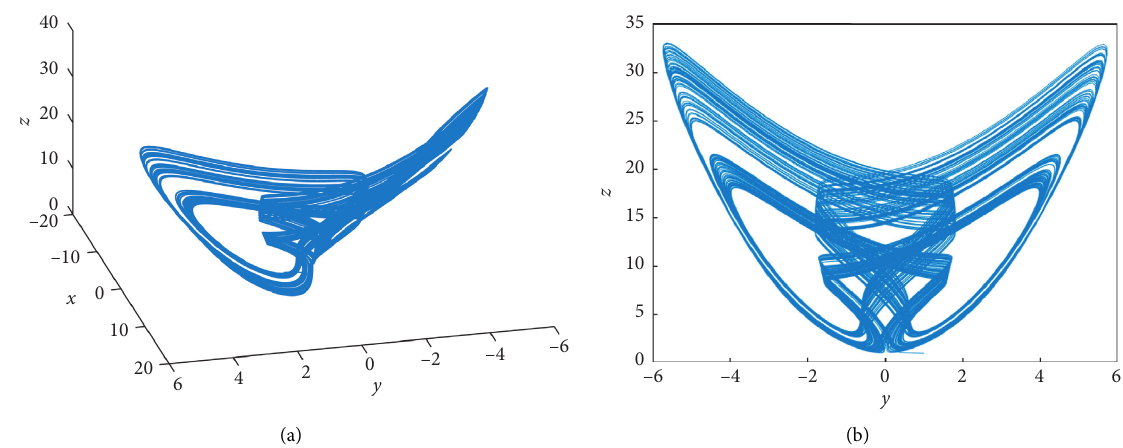
Figure 7: Phase portraits of the fractional system with α � 0 .